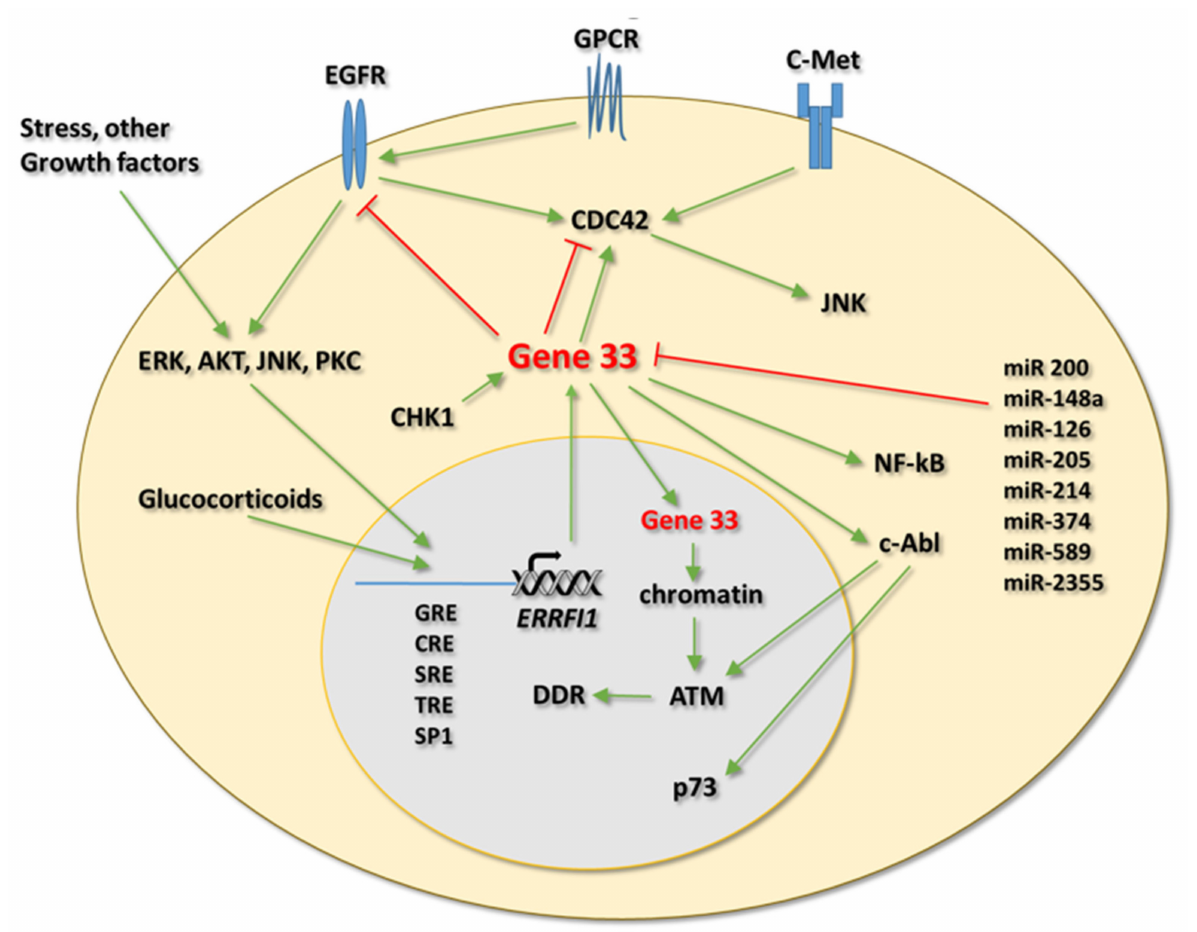
Figure 3. Main regulations and signaling of Gene 33. Abbreviations: DDR: DNA damage response, GPCR: G-protein- coupled receptor. Other abbreviations are Gene names. Green arrows represent activation, Red “T” bars represent